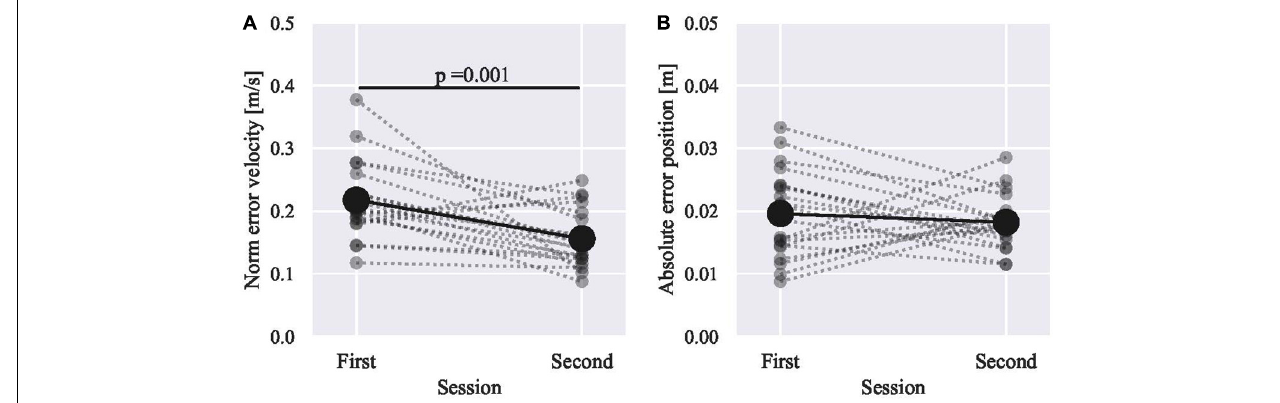
FIGURE 3 | The skill level change between sessions. The average of all participants metric is shown in black, and that of each participant is superimposed in gray. The metric is (A) the norm of error velocity and (B) the absolute error in position. The target peripheral speed is 0.376 m/s, and the radius of the target circle is 10 cm. The paired two-sample tests are Student’s t for the velocity and Wilcoxon signed-rank test for the position.